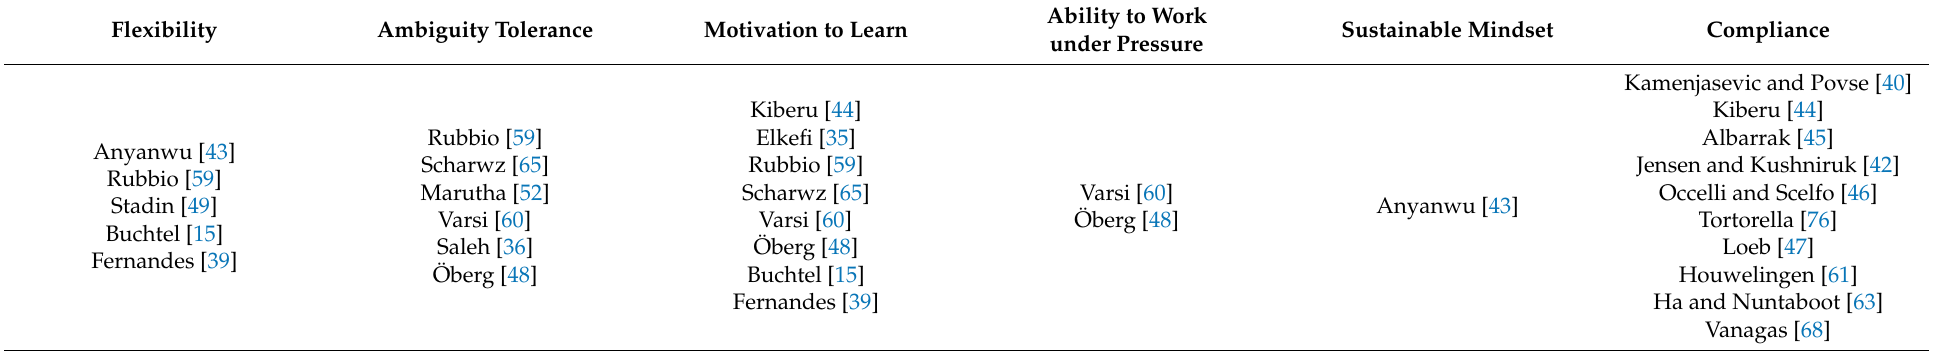
Table 10. Personal competencies for adopting H4.0 ICTs and cited